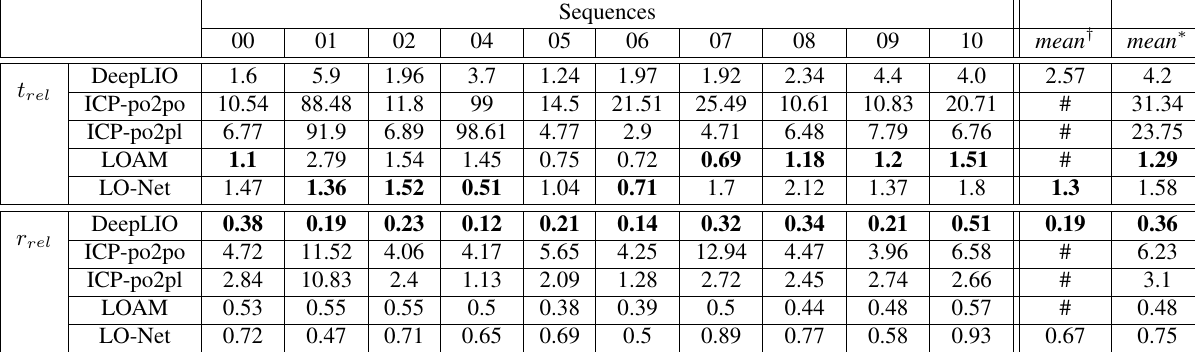
Table 3. Comparison of odometry results of DeepLIO and other methods.